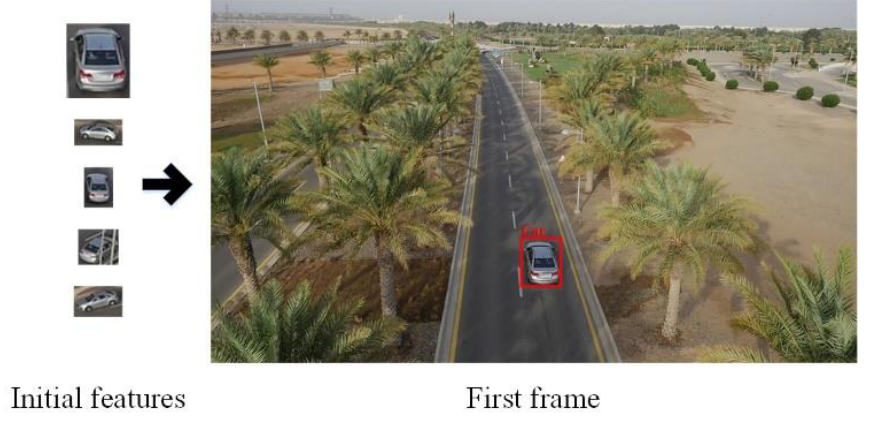
Figure 6. Initializing the SIFT math algorithm with initial features.